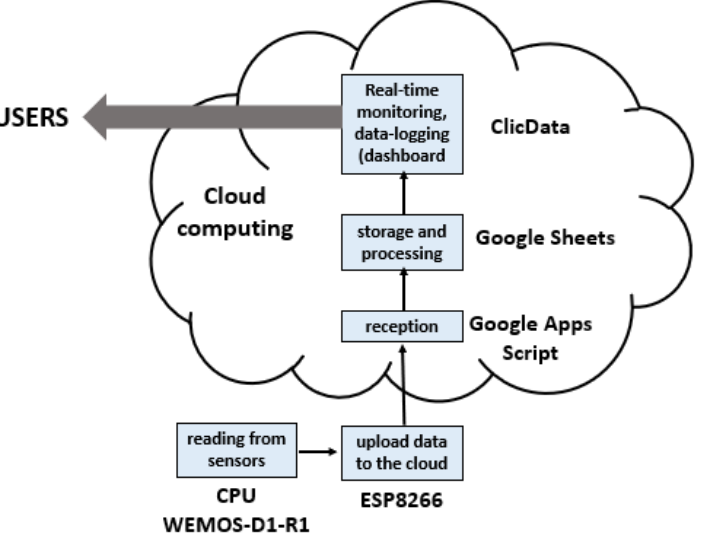
Figure 9. From measurement reading and local processing to online data visualization; dashboard available in the cloud for